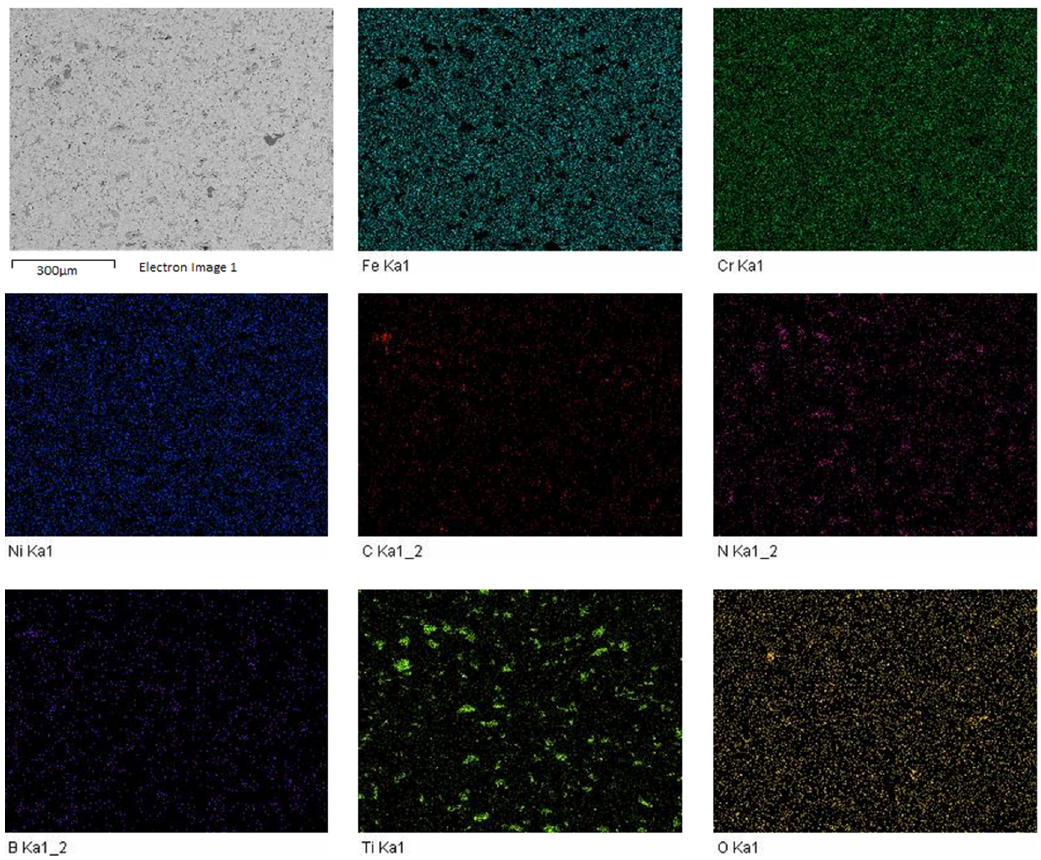
Figure 5. FESEM-EDS elemental maps for 2 wt.% titanium added 316L stainless steel specimens.